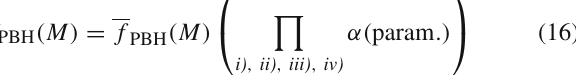
Fig. 4 Left: effective area for prospective optical instruments (see text), adapted from Refs. [10,19,81,82]. We have truncated the effec- tive area of MAST as we are not concerned in > GeV photons for the